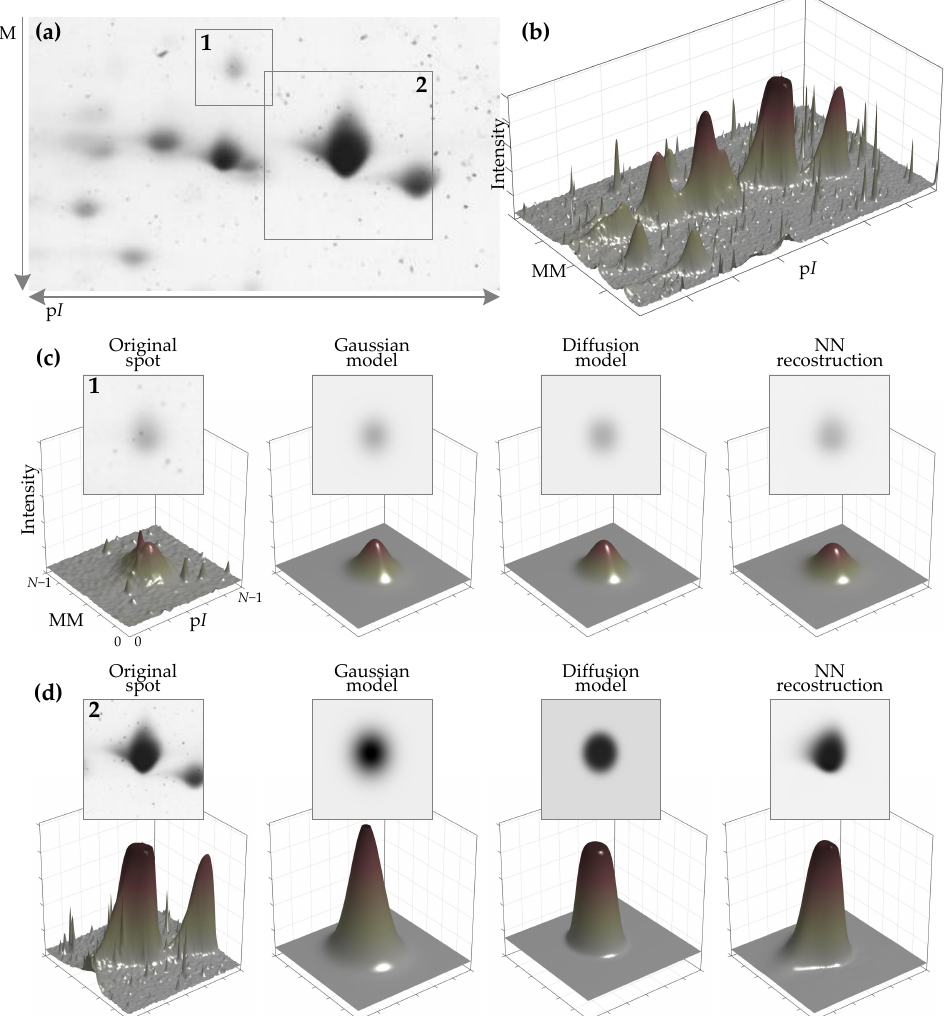
Figure 1. The challenges of 2D electrophoresis gel (2DEG) image analysis. The minimal outcome of the analysis of 2DEG images includes information about visible protein spots: its center coordinates, the intensity of the spot peak, the background intensity, the boundaries of the spot, and the spot’s integrated intensity (volume) are of interest. A small area of a 2DEG image is presented in the usual form ( a ) and as a 3D surface of its inverted intensity ( b ). One approach to estimating the spot’s parameters is to model the spot. Modeling of the protein spot additionally allows isolating the spot from noise and separating it from uneven background. The noise is more clearly visible in 3D surface plots ( b – d ). Modeling results of two spots (areas 1 and 2 of ( a )) are shown in ( c , d ). The results of three modeling methods are: the Gaussian and diffusion process models, commonly met in the literature, are shown in the 2nd and 3rd columns), and the result of spot reconstruction using the method presented in this research based on machine learning tools is shown in the last column. Modeling using Gaussian and diffusion models additionally requires an initial spot mask. The presented method is able to reconstruct the main spot, eliminate the noise, and remove additional spots without any such mask. Additionally, the presented method is better at spot shape and background